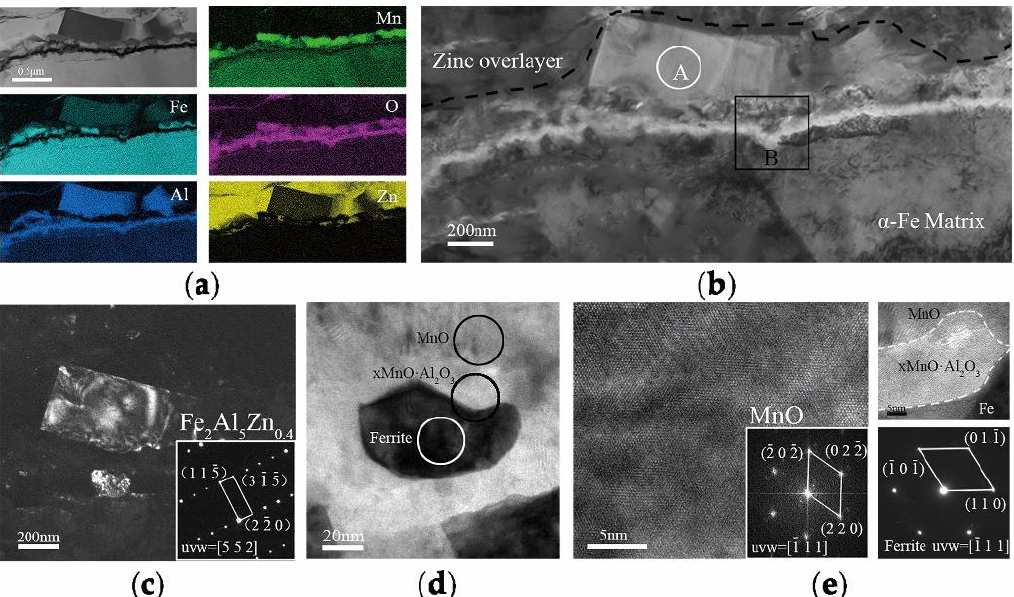
Figure 6. ( a ) STEM cross-sectional elemental maps of the coating/substrate interface and subsurface of the galvanized 10Mn steel annealed under the 243 K ( − 30 °C) DP process atmosphere. ( b ) TEM micrograph of the area shown in ( a ). ( c ) Dark filed image and diffraction pattern of the inhibition layer corresponding to zone A in ( b ). ( d ) Enlargement of the area corresponding to zone B in ( b ). ( e ) Detailed lattice information of MnO, xMnO·Al 2 O 3 , and Fe corresponding to circle regions in ( d ).